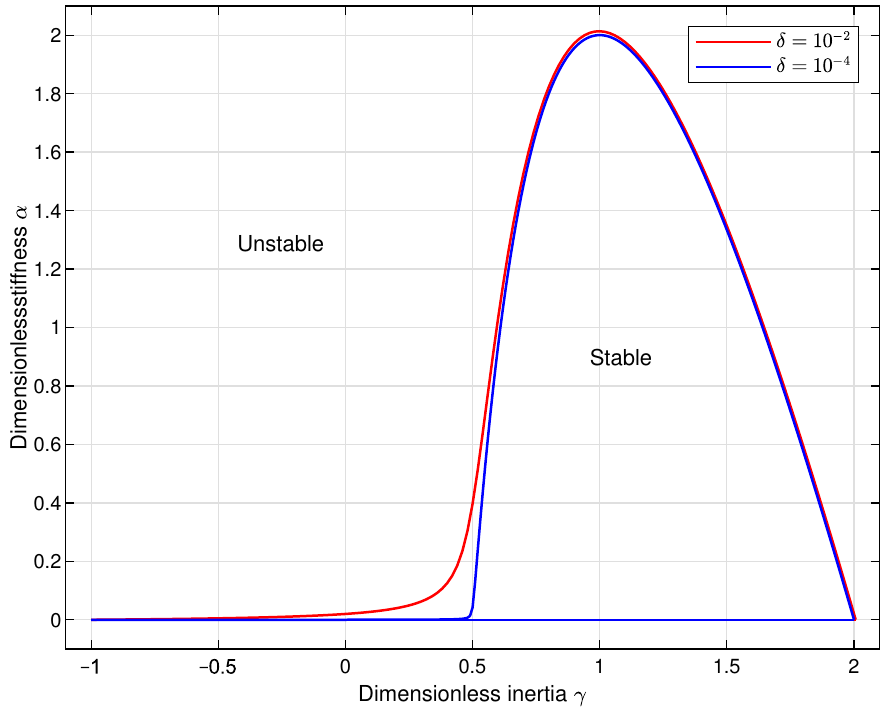
Figure 4. Stability boundaries for virtual spring-mass